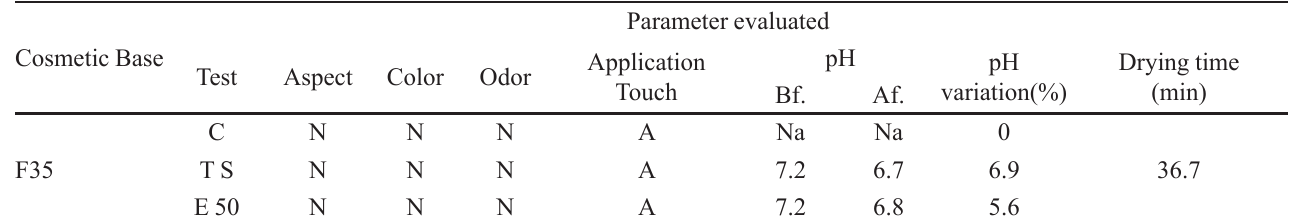
the Screening Study